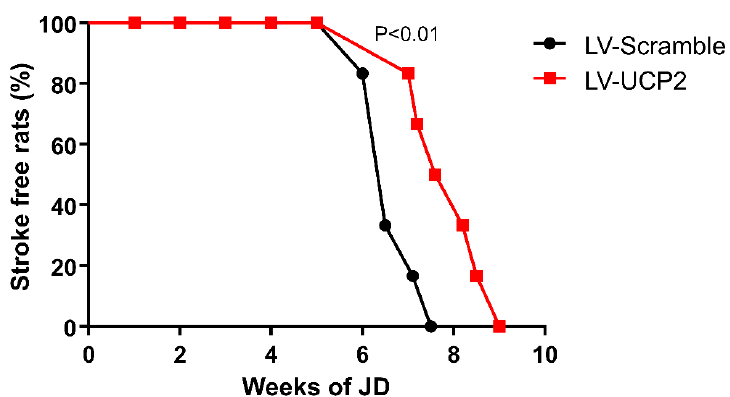
Figure 2. UCP2 brain delivery delayed stroke occurrence in JD-fed SHRSP rats. The graph shows the percentage of stroke-free JD-fed SHRSP rats at different weeks, following a single i.c.v. injection of either LV-UCP2 ( n = 6) or the empty vector (LV-Scramble) ( n = 6). For statistical analysis, see paragraph 4.5.